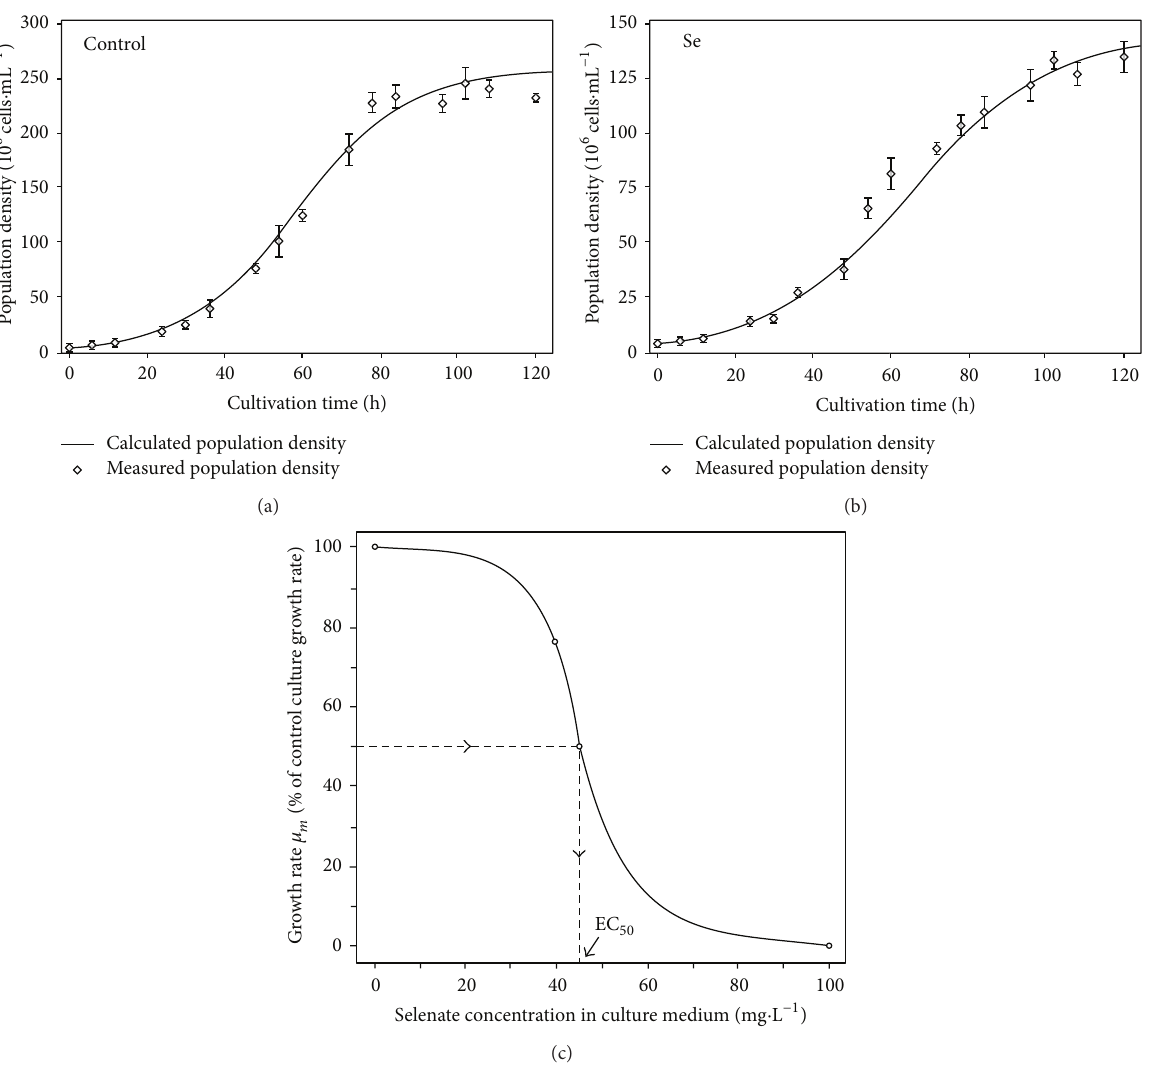
Figure 1: Growth curves of Chlorella sorokiniana culture with 40mg ⋅ L −1 of selenate (a) and control culture (no selenate) (b). Data are given as mean values ± S.D. of the means. Both experimental data of population numbers and data calculated from logistic mathematical model fit are −1 , where 𝑁 0 is the initial graphically presented in Figures 1(a) and 1(b). Model equation used is 𝑁(𝑡) = 𝑁 max ⋅ 𝑁 0 ⋅ (𝑁 0 + (𝑁 max − 𝑁 0 ) ⋅ 𝑒 −𝜇𝑡 ) cell density at time zero, 𝑁 max is the maximal density that cell population can theoretically reach in the indefinite time, 𝜇 𝑚 is and the maximal culture growth rate (h −1 ), and 𝑡 is cultivation time (day). Figure 1(c) presents concentration-response relationship between maximal growth rates from logistic growth models and selenate concentrations in medium. Concentration-response curve was fitted to the 2 parameter log- presumptions were made that concentration logistic model (Hill’s model) using open source software “R statistical package.” To predict EC 50 of 100 mg ⋅ L −1 selenate corresponds to the maximal (100%) growth inhibition, while zero inhibition corresponds to Se-free culture growth value form the log-logistic model curve was 45mg ⋅ L −1 of rate. Obtained EC 50